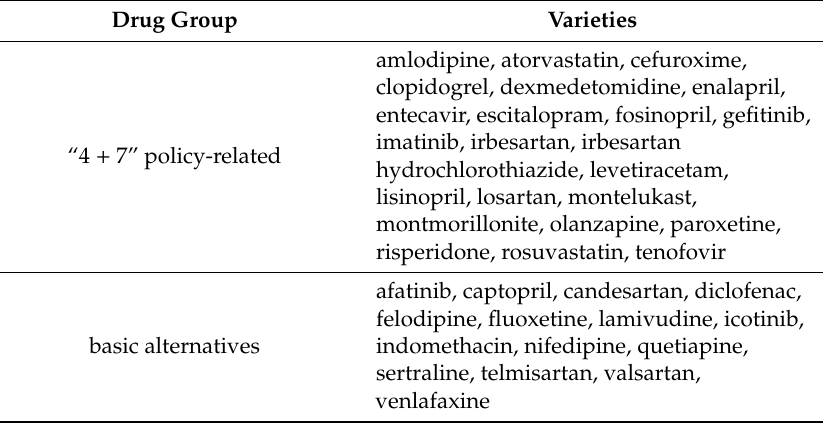
Table A1. “4 + 7” policy-related varieties and basic alternative varieties. Drug Group